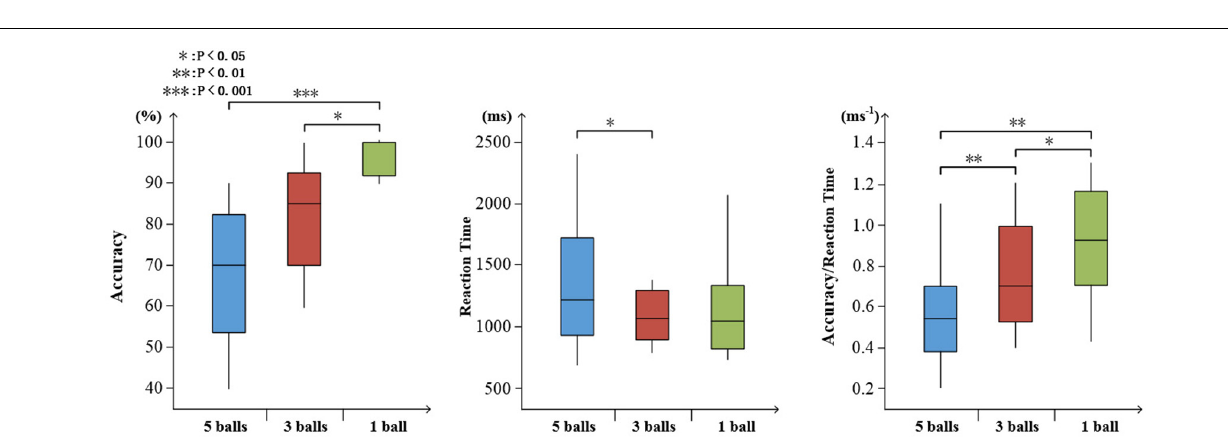
FIGURE 7 | Visualized behavioral data. Statistical analysis for accuracy, reaction time, and the ratio of accuracy to reaction time ( ∗ p < 0.05; ∗∗ p < 0.01; ∗∗∗ p <